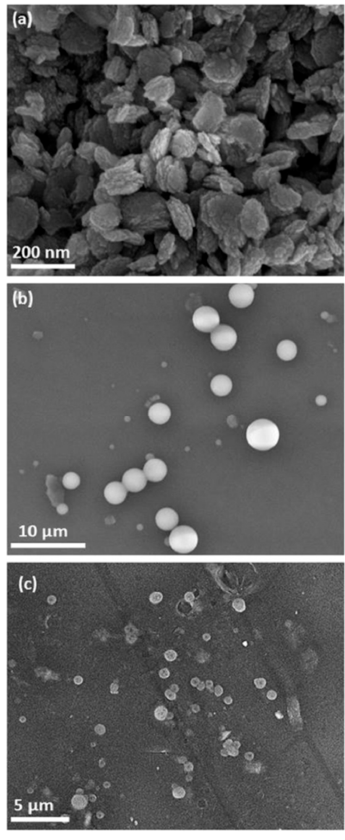
Figure 7. Scanning electron microcopy (SEM) images of ( a ) Zinc oxide nanoparticles ( b